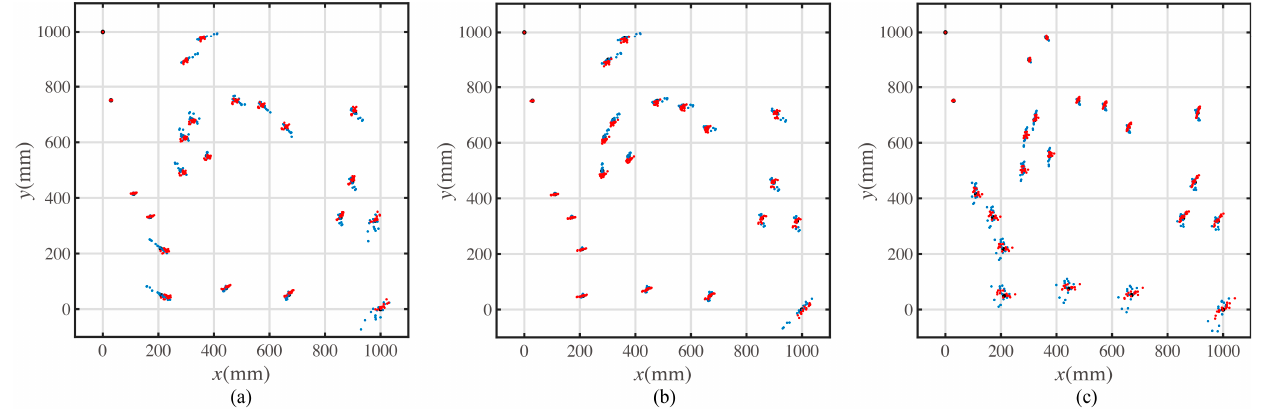
Figure 17. Movement precision experiment with different paths. ( a )The simulated and experimental positions for mobile robot moving along the minimum rotation angle path with command compensation. ( b )The simulated and experimental positions for mobile robot moving along the minimum average position error path with command compensation. ( c )The simulated and experimental positions for mobile robot moving along the minimum forward moving distance path with command compensation. Table 4. Average position error at each target position (mm).